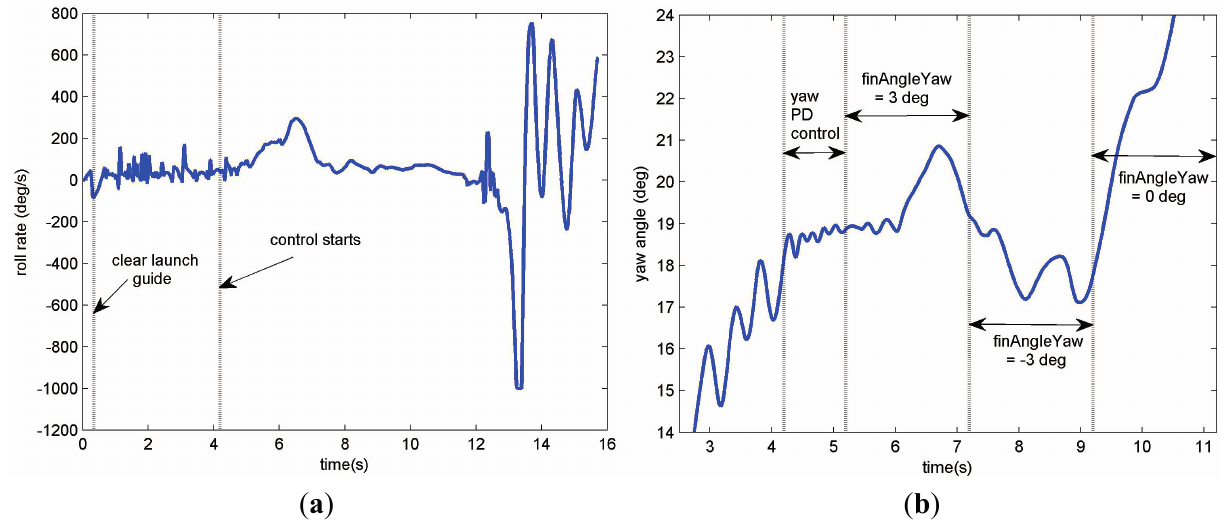
Figure 21. ( a ) roll rate controlled response ( b ) yaw angle controlled response.